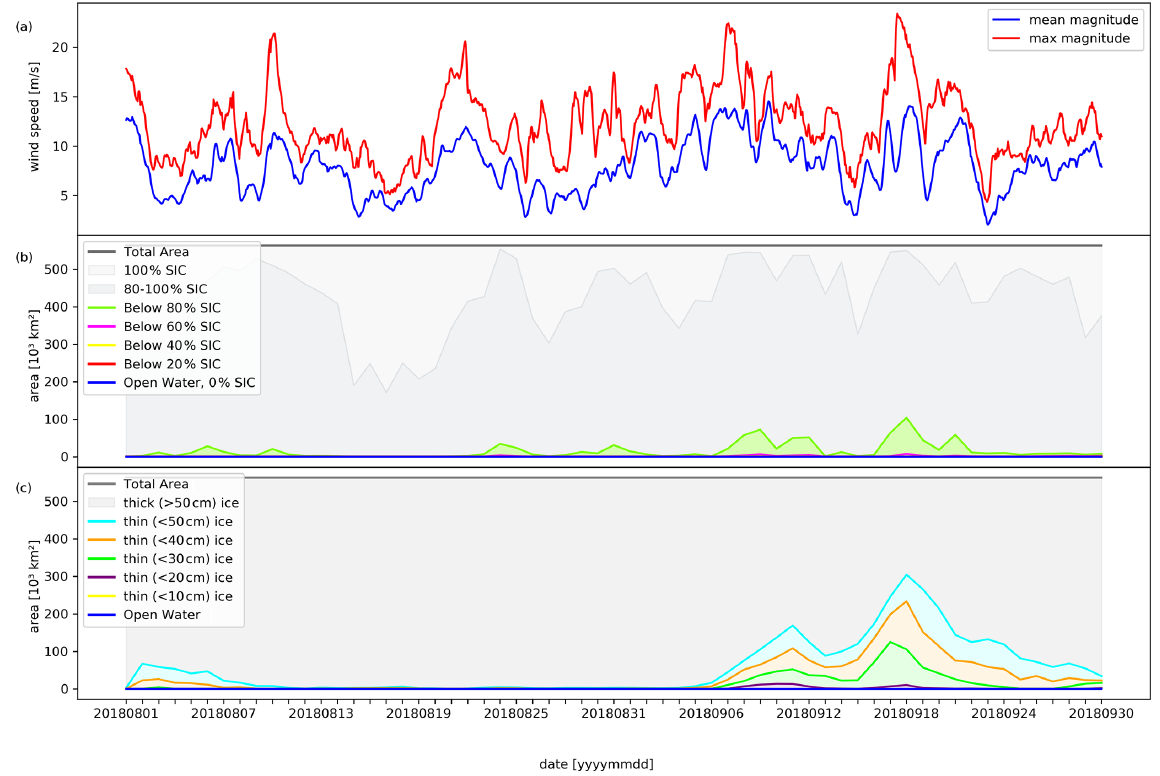
Figure 6. Same format as Fig. 5 for August–September 2018. See Fig. 5 caption for specifications.